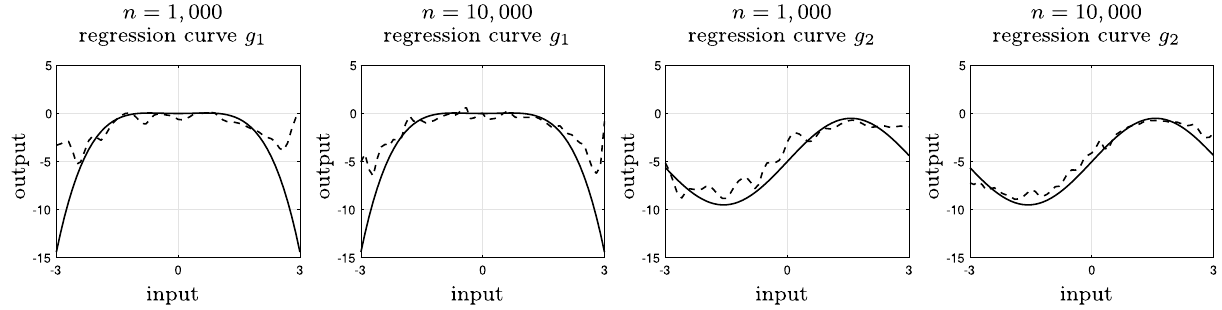
Figure 1. The kernel regression model (dashed black) and true regression curve (solid black) for mixture Gaussian data made differentially private with ǫ